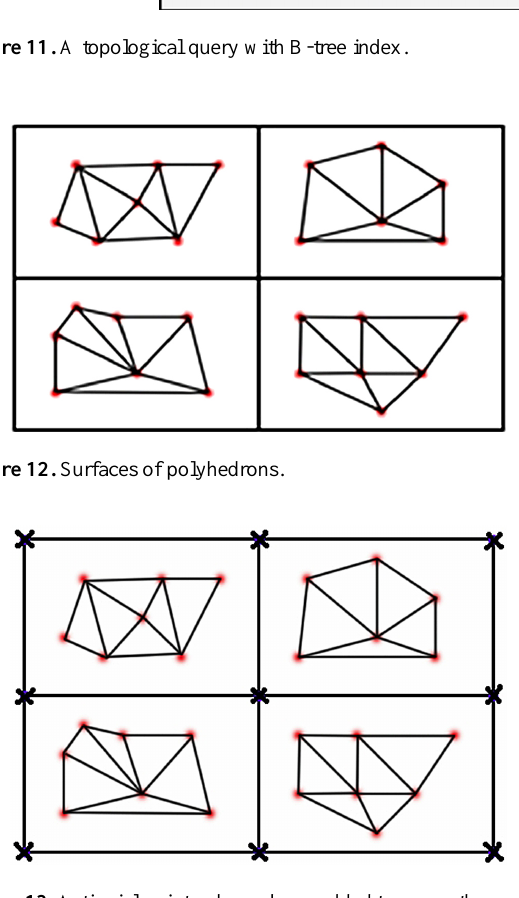
Figure 13. Artificial points, shown by x, added to merge the surface.